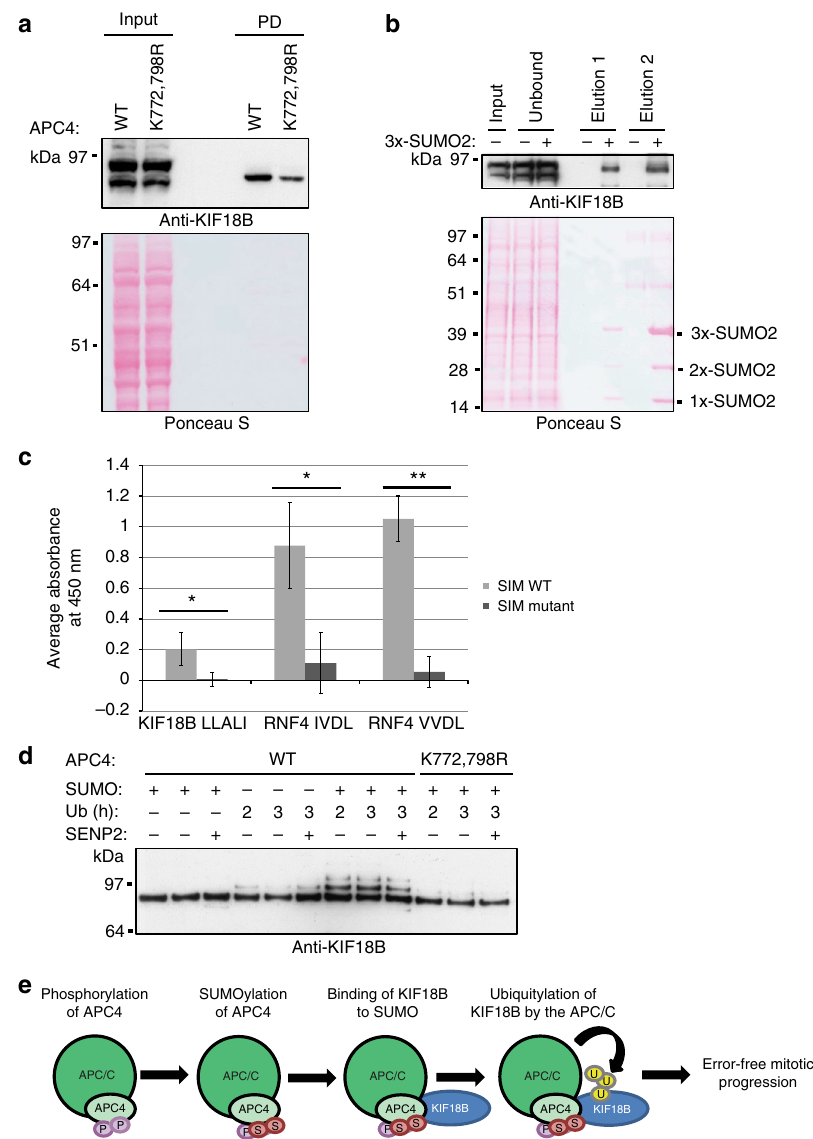
Fig. 7 Binding of KIF18B to SUMOylated APC/C enhances its ubiquitylation. a HeLa lysate and samples taken after co-puri fi cation of potential binders with the Strep-tagged APC/C wild type and mutant were analyzed by immunoblotting with anti-KIF18B antibody. b Recombinantly expressed His-tagged tri- SUMO2 chains (3xSUMO2) were immobilized on beads and incubated with a HeLa lysate. After washing, bound proteins were fi rst eluted with 8 M urea (elution 1) and in a second step with 8 M urea including imidazole (elution 2). To determine whether KIF18B co-puri fi ed with 3xSUMO2, input, unbound, and pulldown samples were analyzed by immunoblotting with anti-KIF18B antibody. Data shown are representative of two individual experiments. c The KIF18B peptide NINRSLLALINVLNA and its corresponding putative SIM mutant NINRSAAAAANVLNA fused to biotin and a PEG linker were immobilized on avidin-coated wells and incubated with 3xSUMO2 chains. Afterwards, an anti-SUMO2/3 ELISA was performed. As a control, SIM-containing peptides of RNF4 and their respective SIM mutant peptides were tested. Mean values and standard deviations were calculated from three technical replicates and a two-sided Student ’ s t -test was performed. p-values: * p < 0.05, ** p < 0.005. Representative results of two independent experiments are shown. d Recombinant APC/C either containing APC4 wild type or APC4 K772,798R mutant was SUMOylated in vitro or treated similarly without UBC9 as a negative control. The co-activator CDH1 and Flag-tagged KIF18B were bound to the complex in vitro and the ubiquitylation machinery was added. The ubiquitylation reaction was either stopped after 2 or after 3 h as indicated. Additionally, SENP2 was added to a third sample after 2 h and the reaction was run for another hour to analyze whether higher molecular weight bands are indeed the result of ubiquitylation and not SUMOylation of KIF18B. KIF18B was visualized by immunoblotting with the anti-KIF18B antibody. This experiment was repeated three times and representative results are shown. e Schematic overview of the effect of APC4 modi fi cation on APC/C function: SUMOylation enhances the recruitment of KIF18B to the APC/C. Thereby, ubiquitylation of KIF18B is facilitated, contributing to error-free progression through